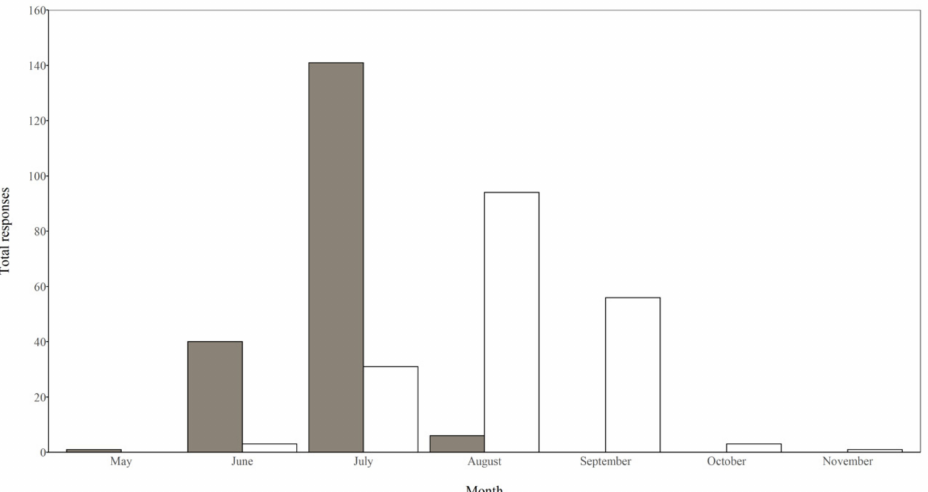
Figure 2. Typical start (shaded) and finish (open) months of prairie hay harvest by ranchers in the Holt and Cherry counties, Nebraska, USA surveyed in